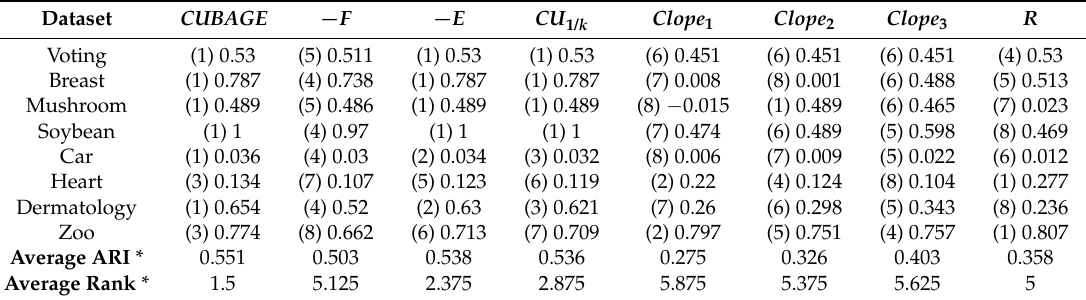
Table 11. Average ARI values of the chosen k -modes partitions over 100 runs ( k fixed to the actual number of